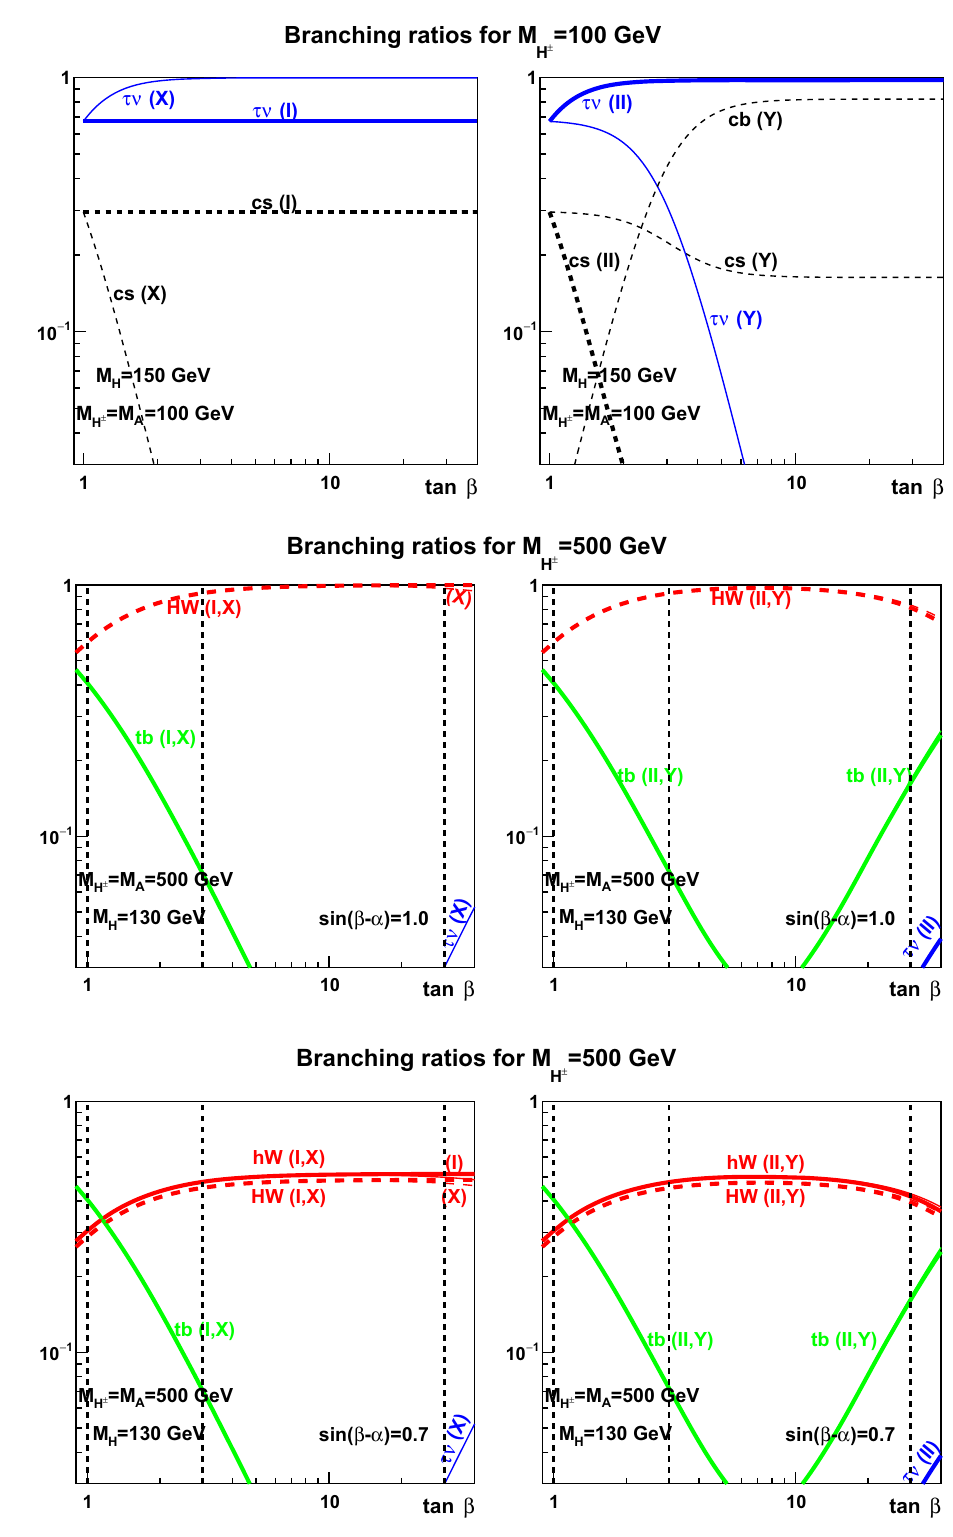
Fig. 1 Light charged-Higgs branching ratios vs. tan β . Left Models I and X, right Models II and Y. The panel on the right is only for illustration, such a light H + is excluded for the models II and Y